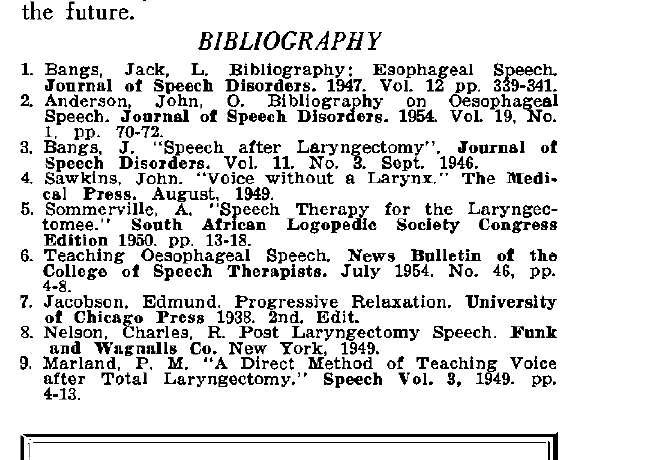
syllabled words. Phrases and sentences should be introduced without